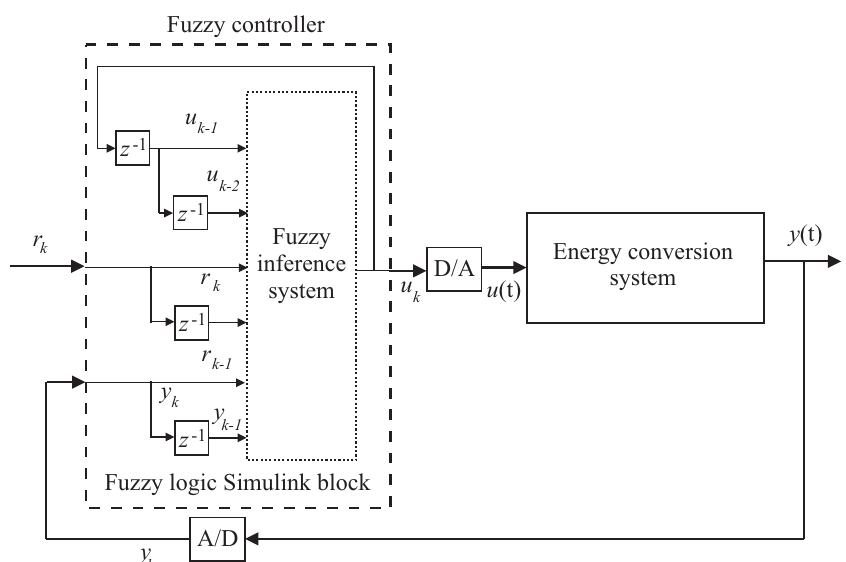
Figure 6. Block diagram of the monitored system controlled by the fuzzy